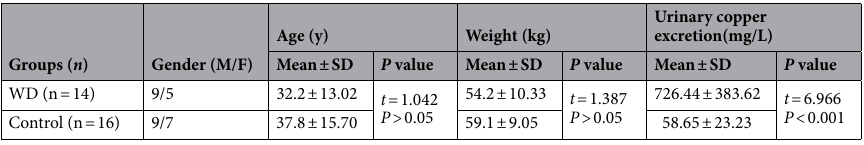
Table1. The baseline data of all